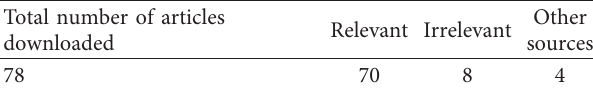
Table 1: Total number of articles for literature